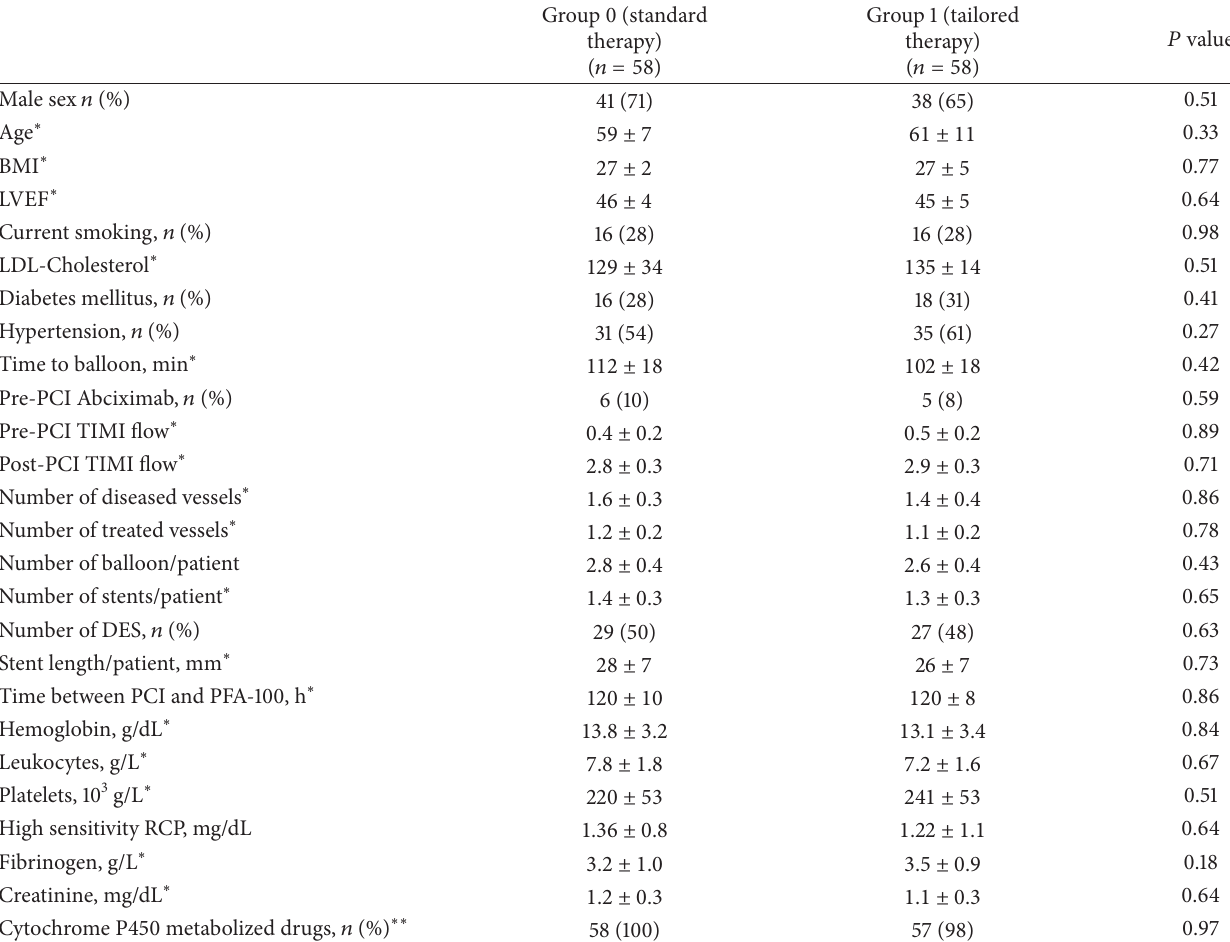
Table 1: Clinical, hemodynamic, and laboratory data of patients